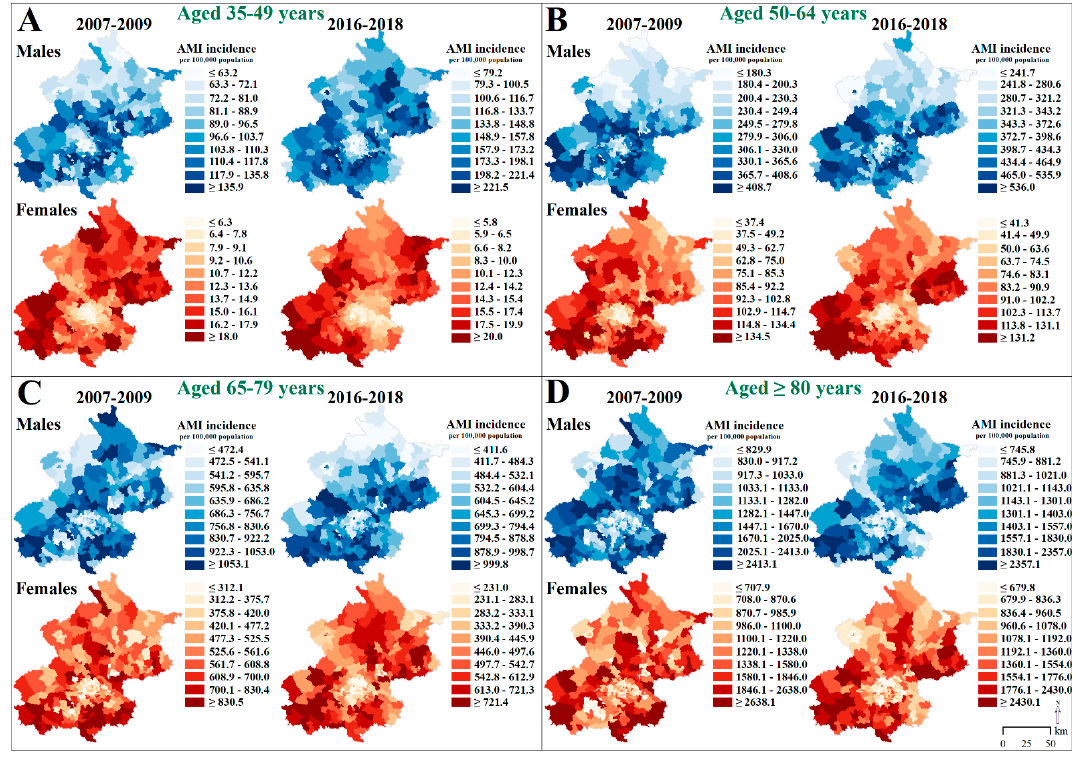
Figure 2. Deciles of the Incidence of Acute Myocardial Infarction by Age–Sex Groups at the Township Level in Beijing, 2007–2018. AMI indicates acute myocardial infarction. Overall, the absolute geographic inequality, which was defined as the difference be- tween the 90th and 10th percentile of the AMI incidence rate in townships, increased slightly from 173.8 per 100,000 population in 2007–2009 to 188.1 per 100,000 population in 2016–2018. Moreover, the relative geographic inequality, defined as the ratio of the 90th to the 10th percentile of the AMI incidence rate in townships, were 2.2 and 2.3 in 2007– 2009 and 2016–2018, respectively. The increase in relative geographic inequality was more apparent in the case of young residents aged 35–49 years (2.1 to 2.8 for males and 2.8 to 3.4 for females) compared with older residents aged 65–79 years (2.2 to 2.4 for males and 2.7 to 3.1 for females) and those aged ≥ 80 years (2.9 to 3.2 for males and 3.7 to 3.6 for females) (Table 2).